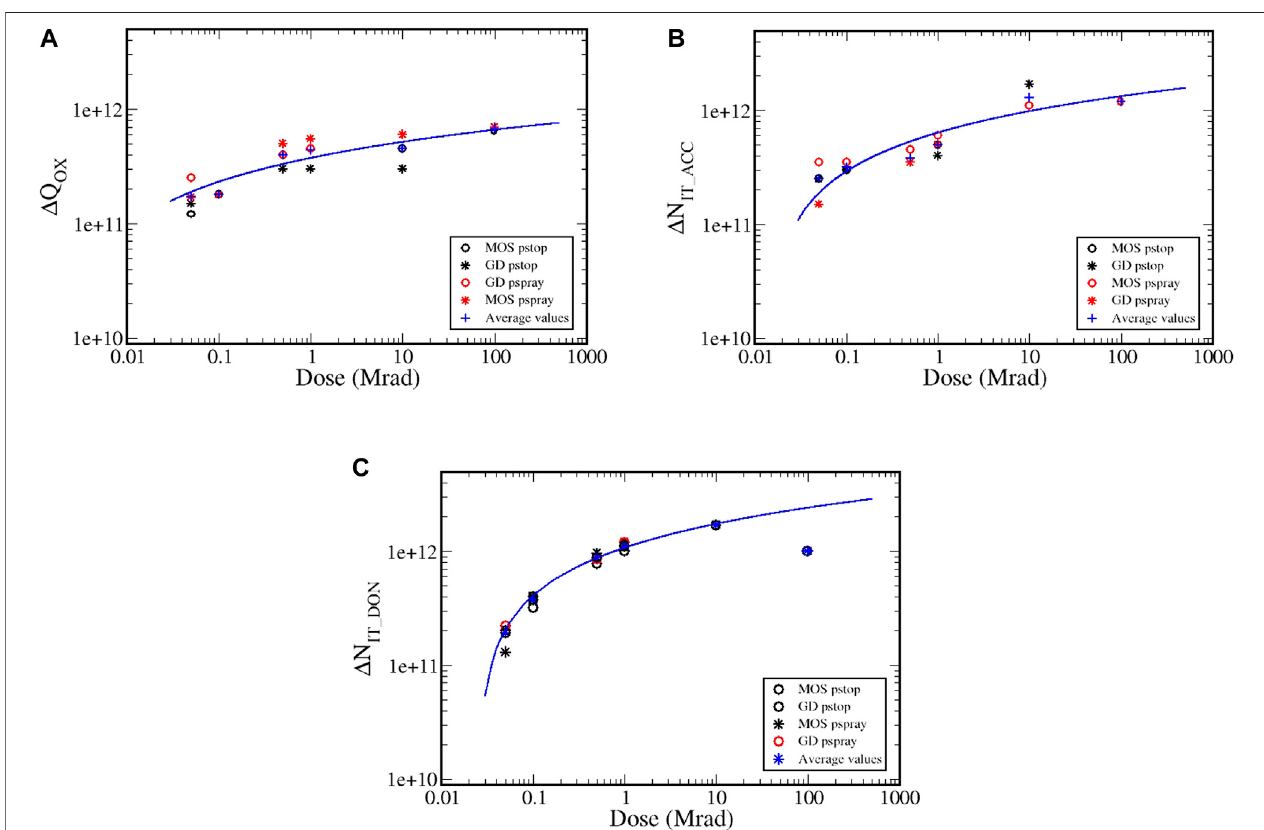
FIGURE 3 | Input parameters ( fi tting curves) for “ Perugia 2019 Surface ” modeling HPK silicon devices: (A) Oxide charge density increase. (B) Acceptor-like interface trap state density increase (C) Donor-like interface trap state density increase.